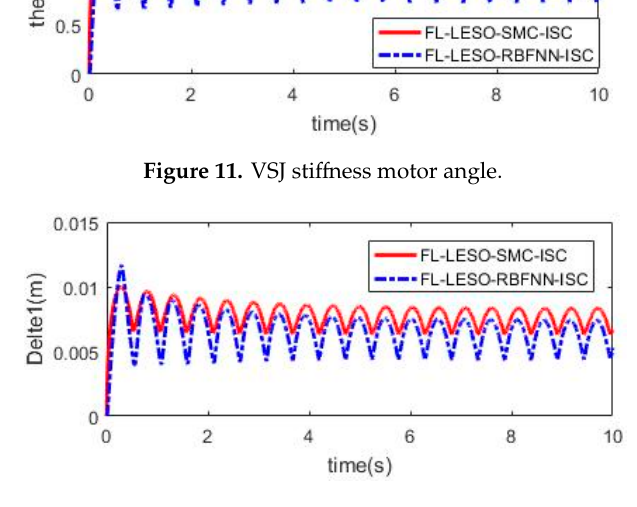
Figure 12. VSJ lever arm.